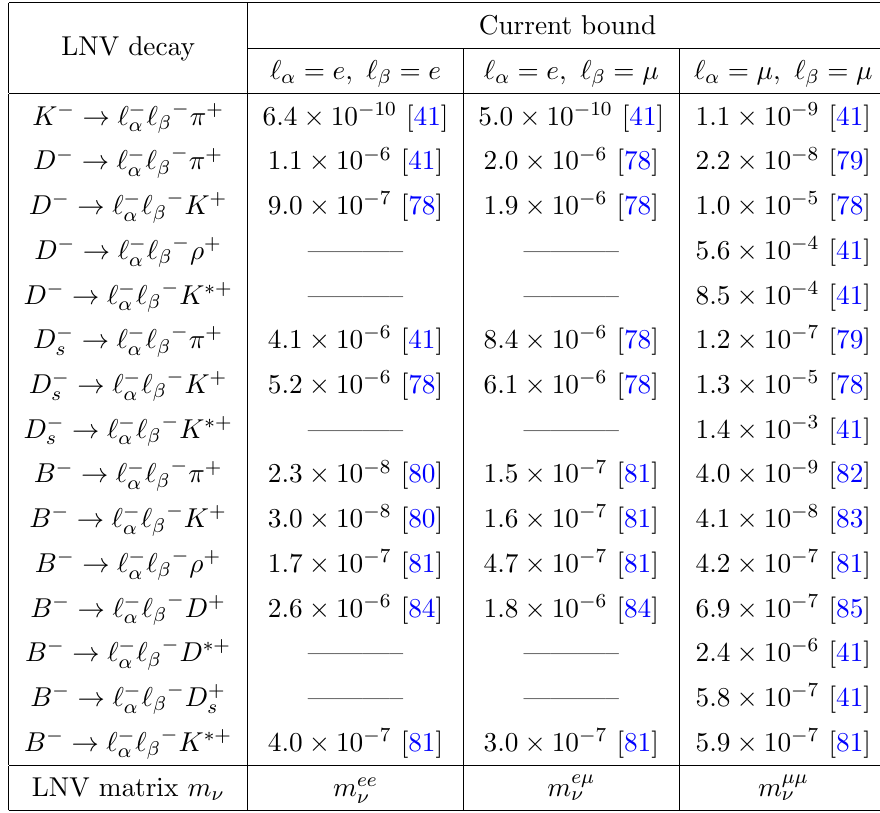
Table 2 . LNV meson decay processes. The current bounds for Kaon, D and B meson decays were obtained by Belle [84], BABAR [78, 80, 81] and LHCb [79, 82, 83, 85], and have been summarised in [41,